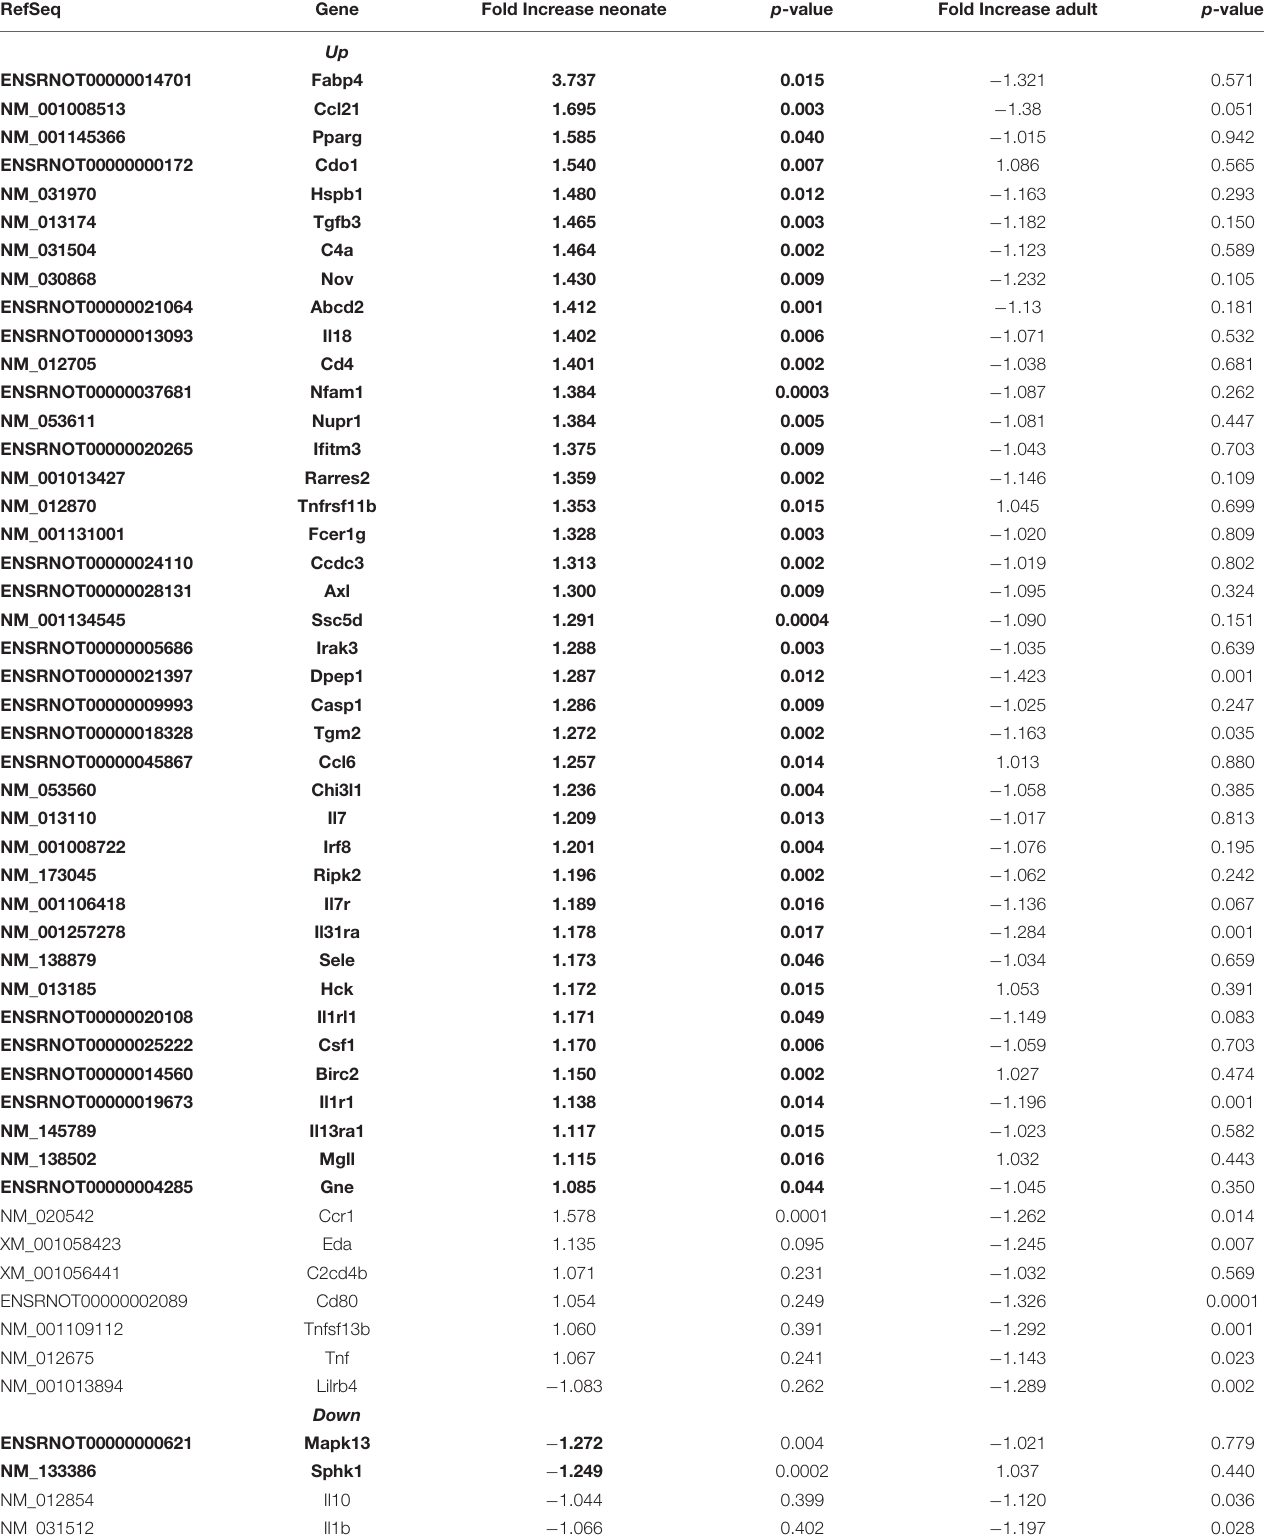
TABLE 3 | Effect of MatSep on inflammatory gene expression trajectory from neonate-to-adult life. RefSeq Gene Fold Increase neonate p -value Fold Increase